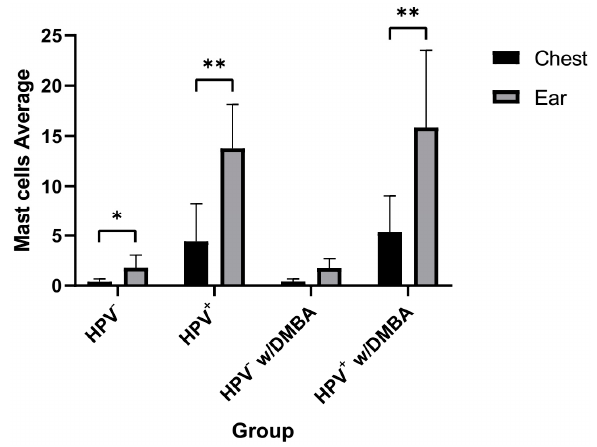
Figure 3. Mast cell differential infiltration in each group (chest skin and ear tissue together). There